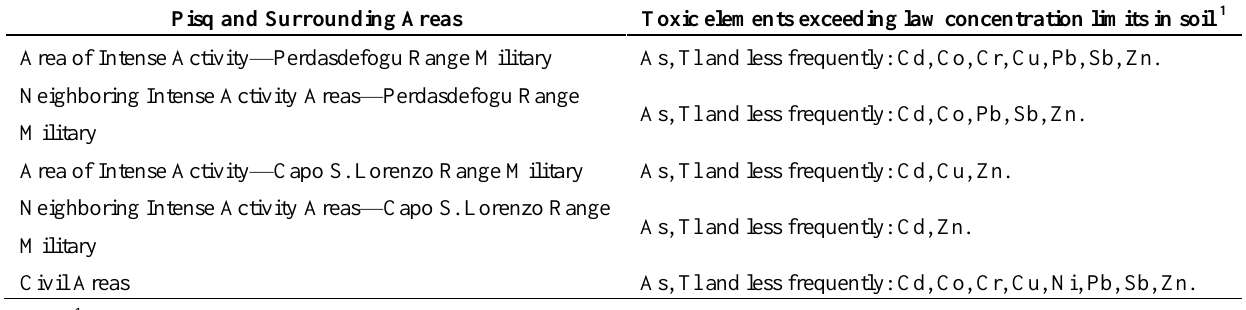
Table 2. Toxic element residues in soils